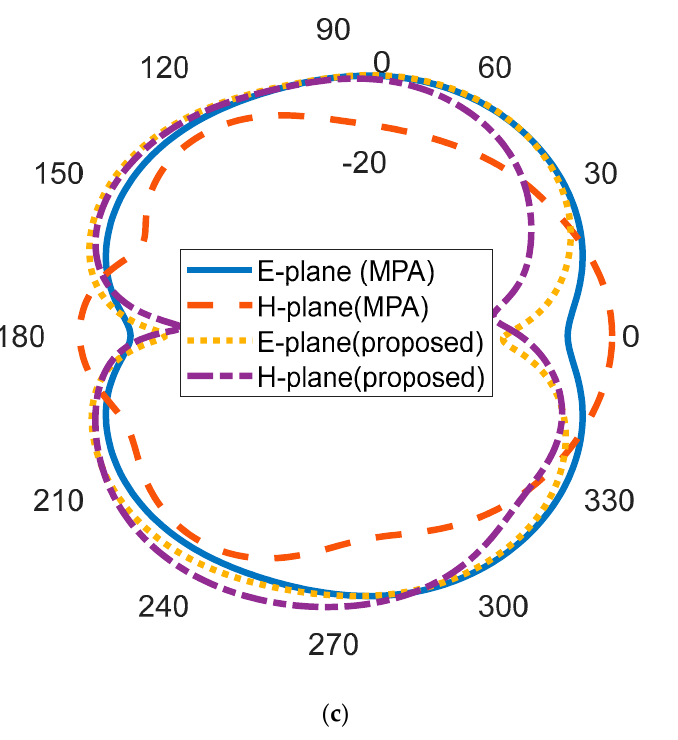
Figure 9. Radiation patterns of the rectangular MPA and proposed antenna at: ( a ) 6.18 GHz ( b ) 9.65 GHz ( c ) 11.5 GHz.